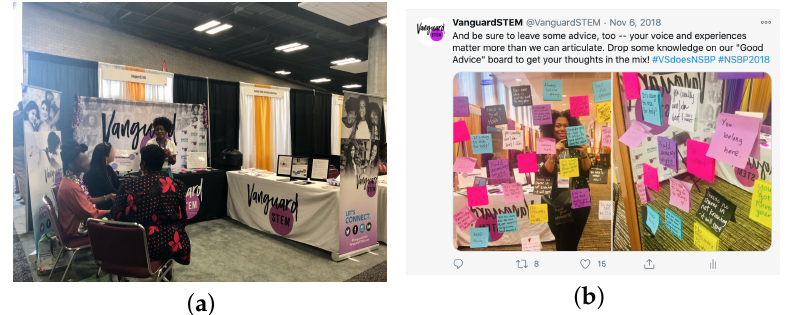
Figure 3. The #VanguardSTEM Conference Crashing initiative brought our previously digital-only content into the ( a ) real world to take up physical space and materialize our hyperspace at STEM conferences. We used the physical space to build up a “Good Advice” board ( b ) where visitors to our booth could leave advice or get advice, thus contributing to STEM identity of building alignment and a sense of connection to the community of women and non-binary people of color attending the same